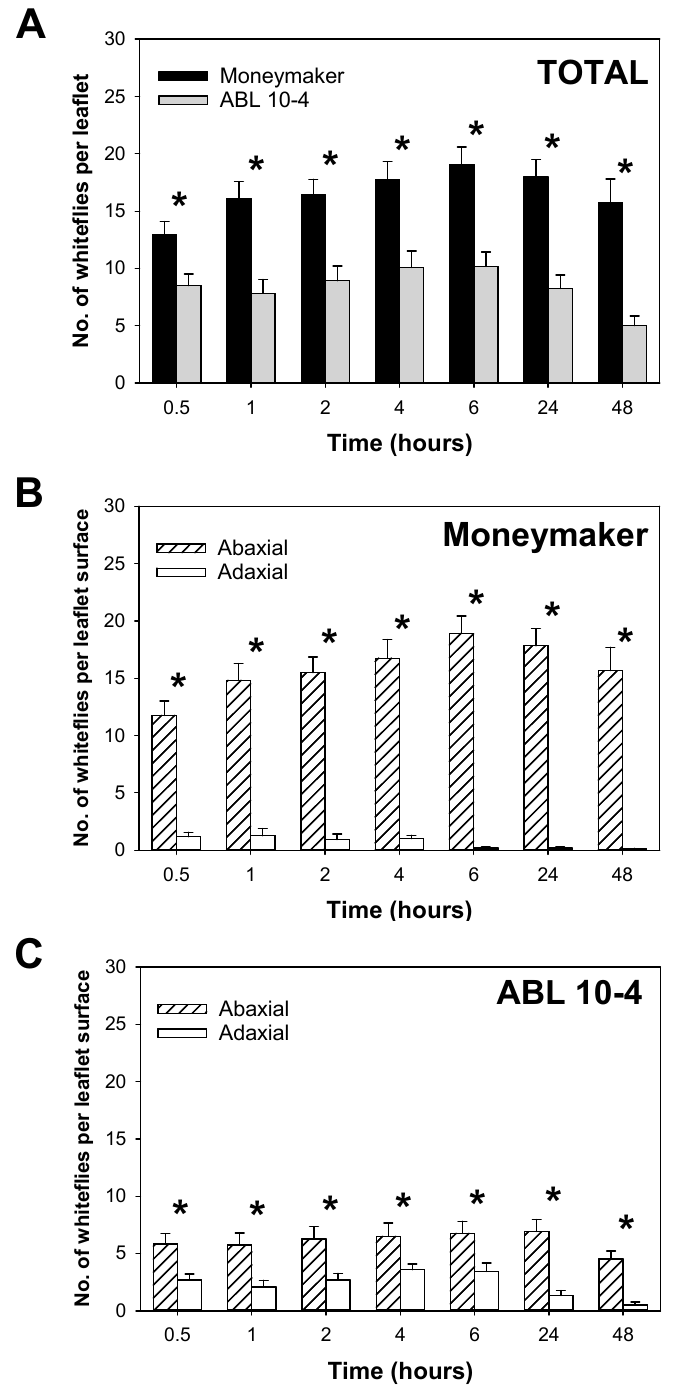
Figure 3. Trialeurodes vaporariorum settling on leaves of Moneymaker and ABL 10-4 near-isogenic tomato lines in non-choice conditions calculated at different times after the release of five T. vaporariorum adult whiteflies on Moneymaker and ABL 10-4 test leaflets at the center of arena. ( A ) Total number of whiteflies settling on any of the leaf surfaces of Moneymaker vs. ABL 10-4, ( B ) number of whiteflies on abaxial vs. adaxial leaf surface of Moneymaker, and ( C ) on abaxial vs. adaxial leaf surface of ABL 10-4. Asterisks indicate significant differences ( p = 0.05) at each time point based on LS means test under generalized linear models (Log link, Poisson distribution) analyses; bars indicate the standard error of the mean.